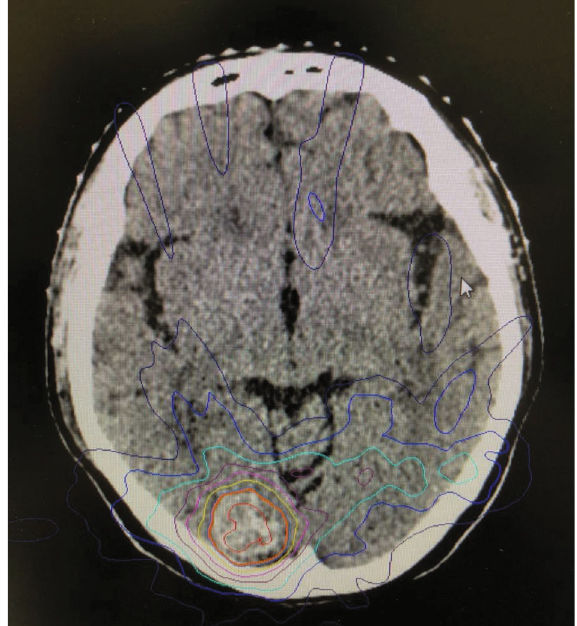
Figure 2: SBRT plans for brain metastasis patient. The patient was a 59-year-old female with adenocarcinoma stage II NSCLC with brain metastases in the right occipital